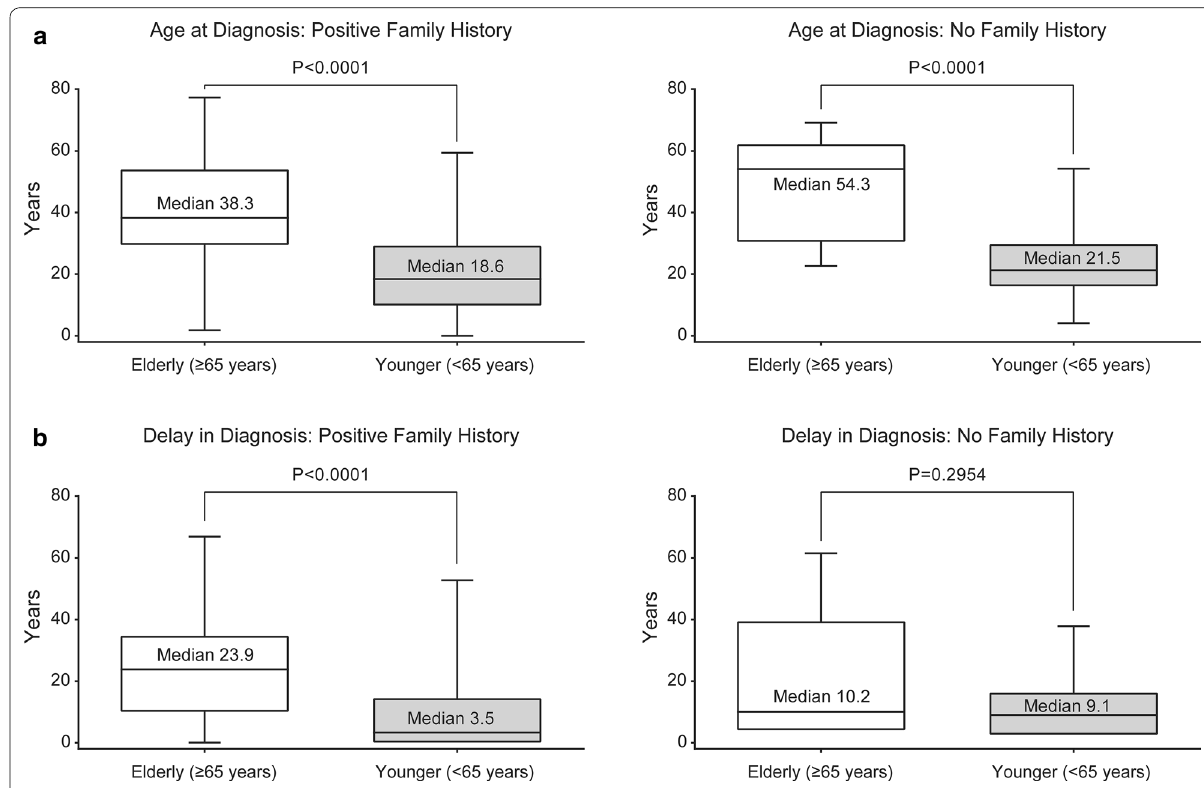
Fig. 1 a Age at diagnosis in elderly and younger patients, with and without a family history and b delay in diagnosis in elderly and younger patients, with and without a family history a . The horizontal line inside each box indicates the median, the lower and upper borders of each box indicate the first and third quartiles, and the lowest and highest horizontal lines outside the box indicate the minimum and maximum value. a A total of 113 patients with a family history had a negative delay in diagnosis (wherein diagnosis occurred before onset of symptoms, based on confirmatory laboratory testing); younger, n 108; elderly, n 5. Likewise, a total of five patients with no family history had a negative delay in = = diagnosis, all in the younger